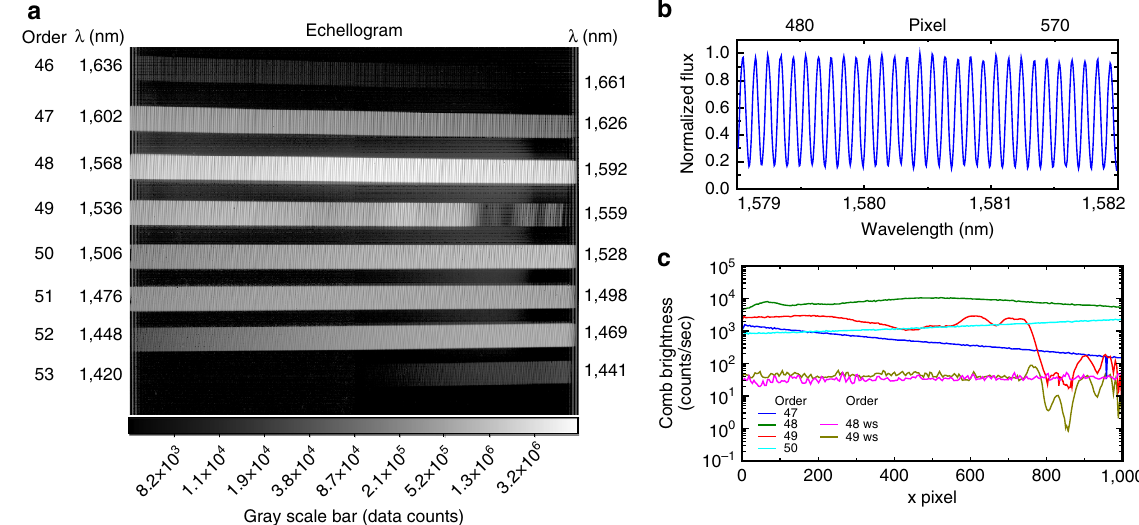
Figure 5 | Data from testing at Keck II. ( a ) Reduced NIRSPEC image from echelle order 46–53, displaying the stabilized laser comb using the 1,559.9nm reference laser. Line brightness represents data counts. ( b ) A portion of the extracted comb spectrum from order 48 is plotted versus wavelength. ( c ) Comb brightness envelope of orders 47–50 and orders 48 and 49 when flattened by a waveshaper